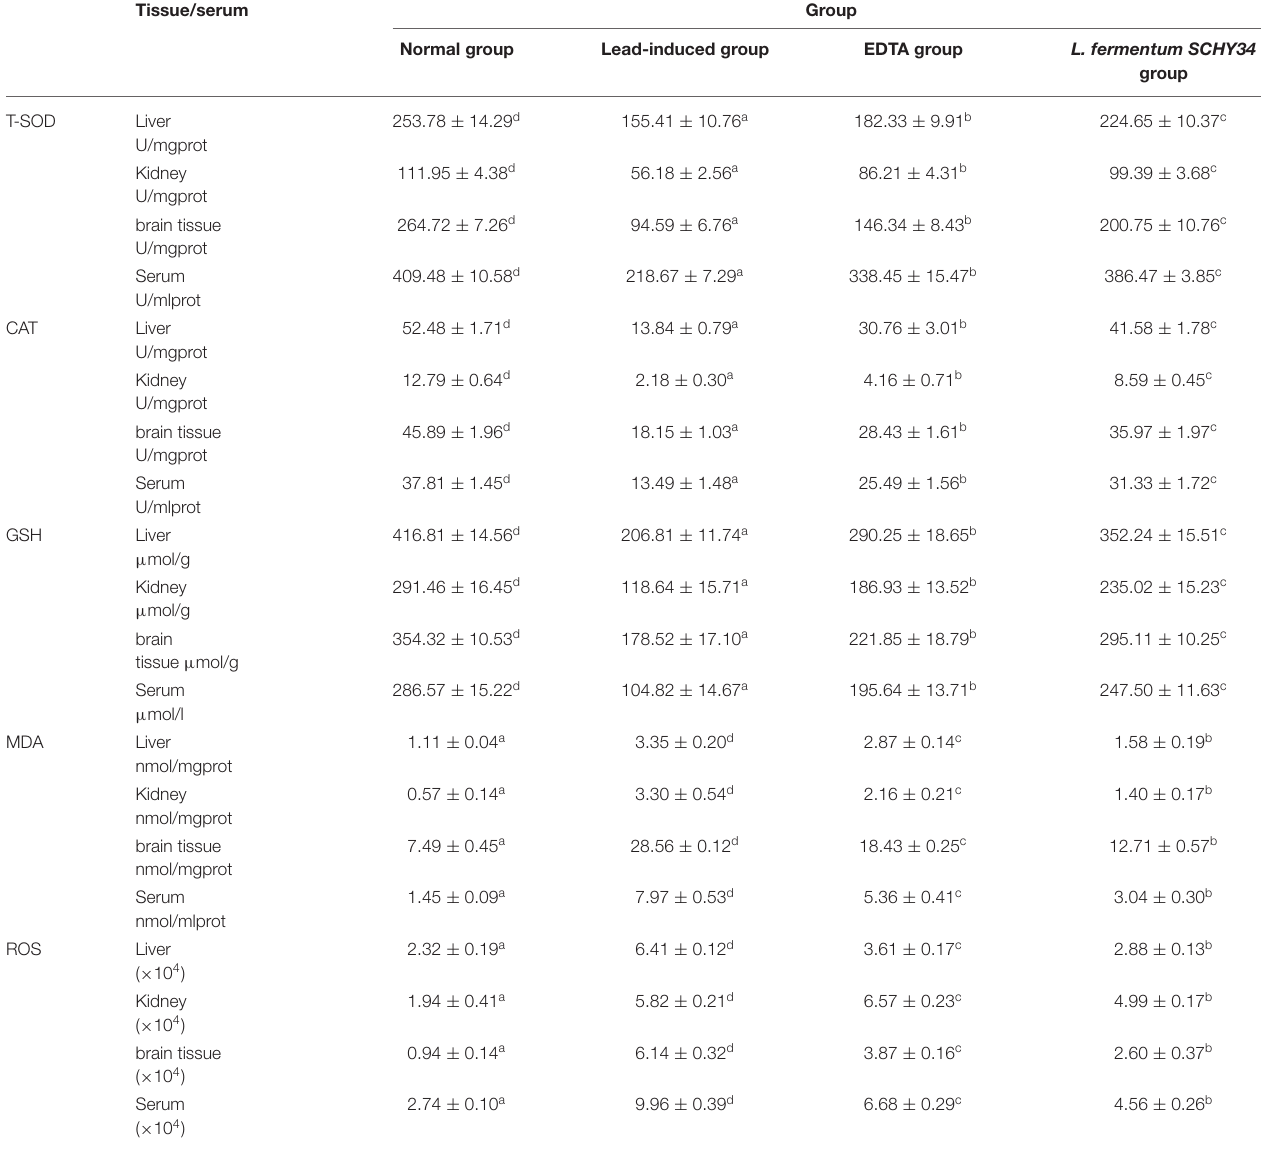
TABLE 5 | Oxidation indexes (T-SOD, CAT, MDA, GSH, and ROS) in liver, kidney, brain tissue, and serum of SD rats.